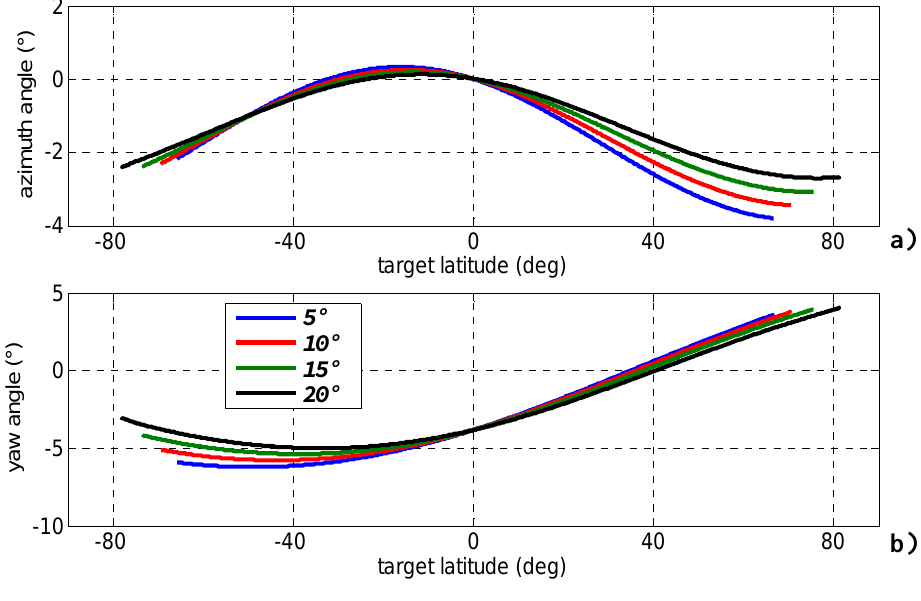
Figure 8. Bistatic antenna azimuth angle (a) and bistatic spacecraft yaw steering angle (b) for four bistatic antenna off-nadir angles within the range of covered latitudes.